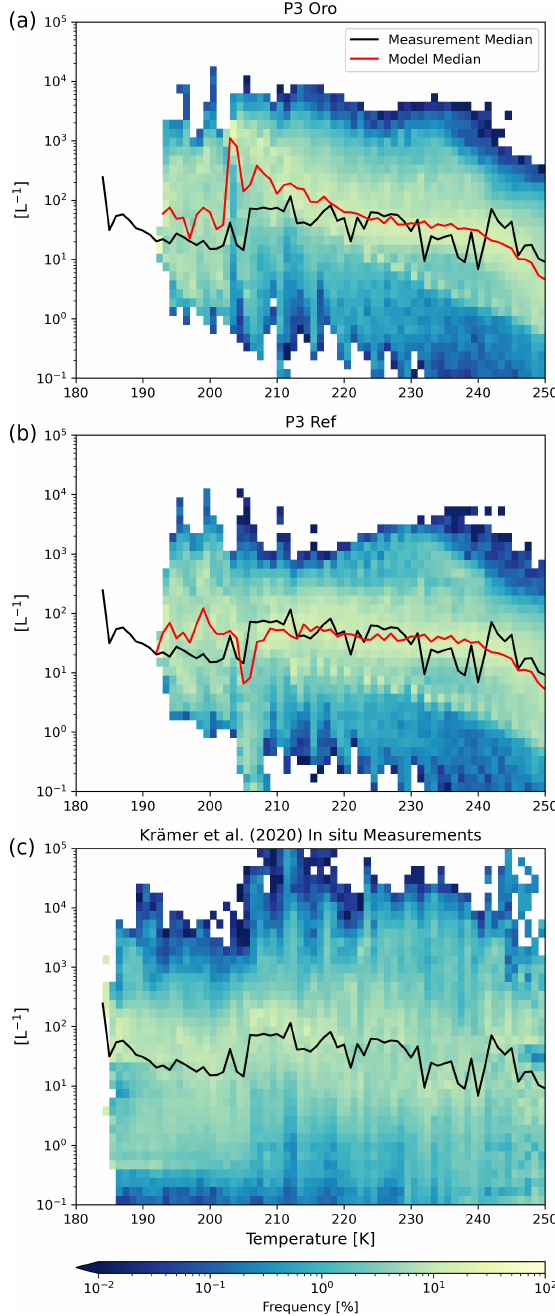
Figure A1. ICNC (L − 1 ) frequency diagrams for ice crystals with a diameter of at least 3µm as a function of temperature between 180 and 250K binned like in Krämer et al. (2020) for every 1K. The 5- year global mean data from the model with the orographic vertical velocity based on Joos et al. (2008, 2010) activated are plotted in panel (a) , the 5-year global mean data for the “Full_D19” as in the main paper are plotted in panel (b) , and the compilation of in situ flight data from Krämer et al. (2020) is plotted in panel (c) . The red line in the upper plot represents the binned median ICNC value of the model data, and the black line in both plots is the same value for the observational